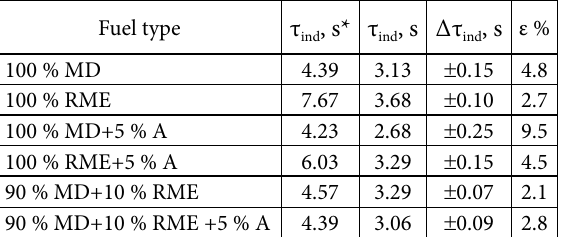
Table 2. Single droplet ignition delay time measurement results for the various types of fuels. Initial droplet radius r mm (τ